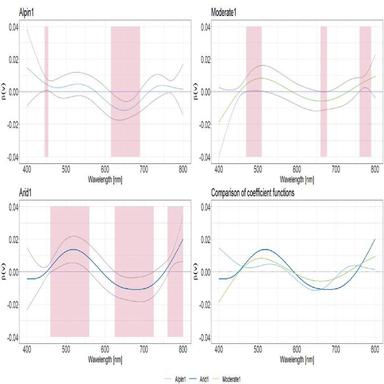
Fitted coefficient functions βl (ν) from the functional mixed effects model, l ∈ , with 90% confidence bands. The areas where the coefficient functions are significantly different from zero are highlighted in red.